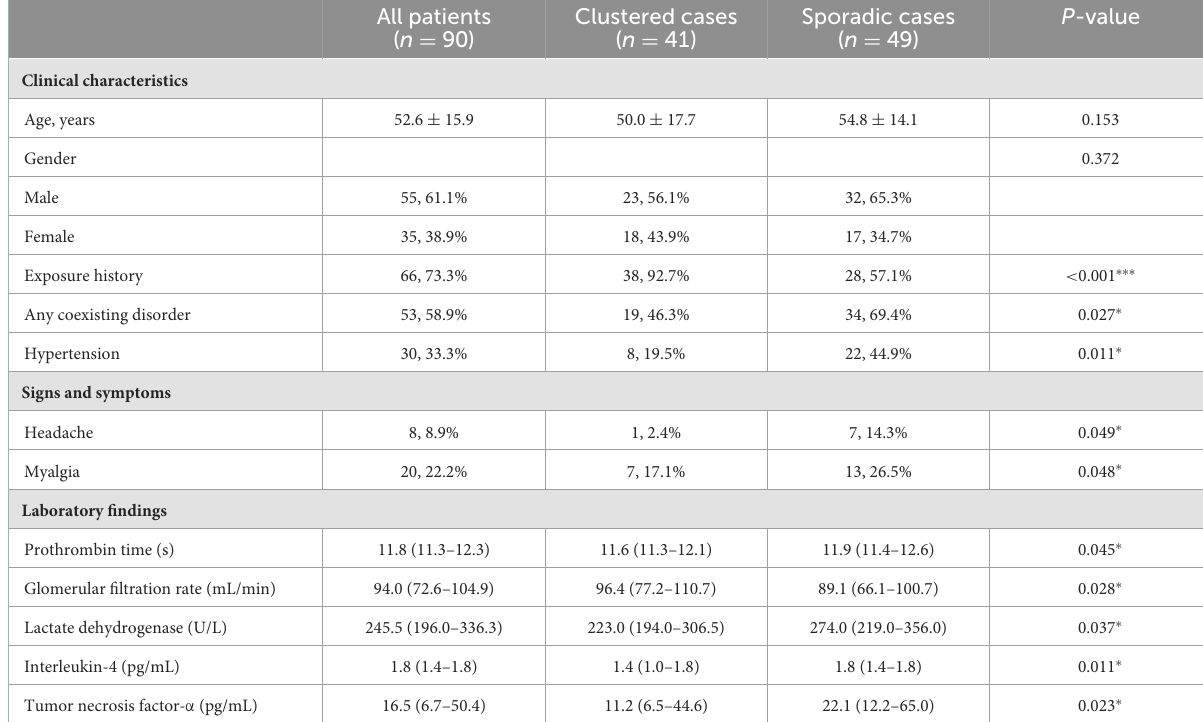
TABLE 1 Clinical characteristics and laboratory findings of 90 patients with laboratory confirmed coronavirus disease 2019